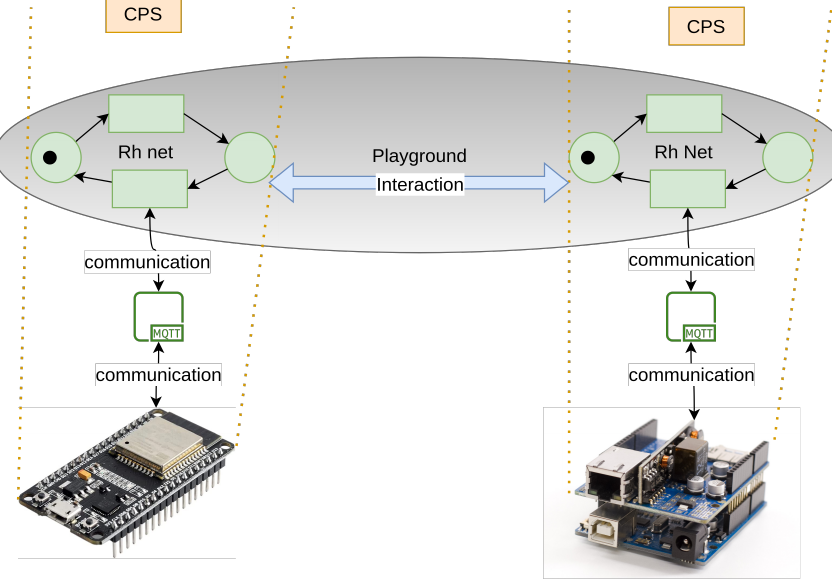
Figure 7. CPS concept on PRESIB